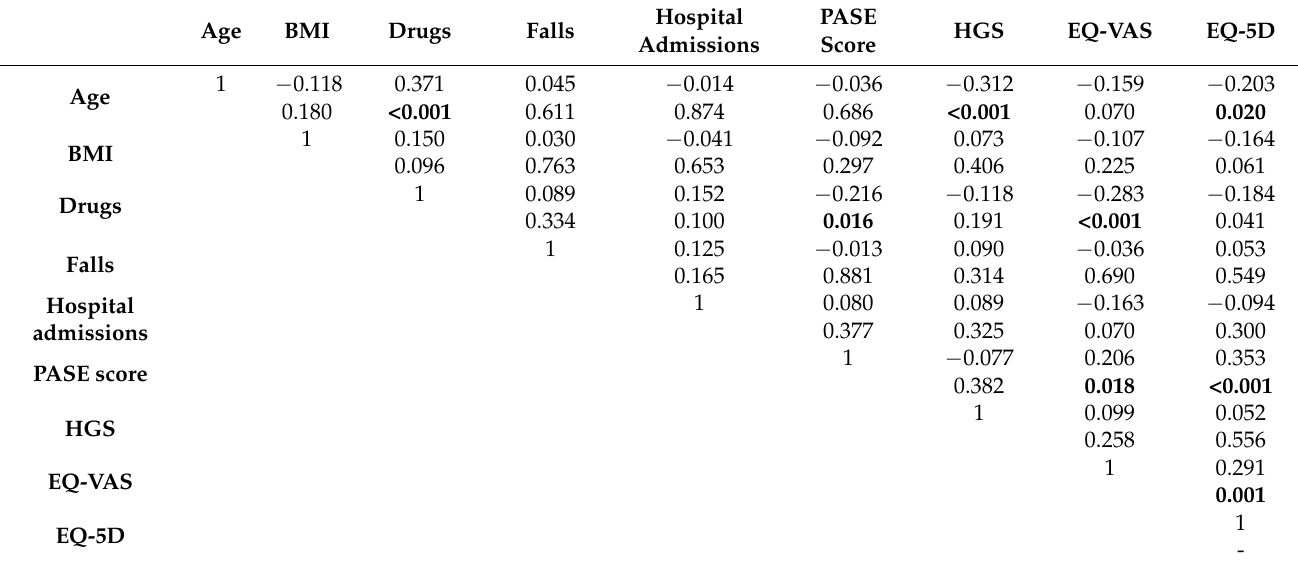
Table 2. Pearson correlation coefficients of the analyzed variables in men.